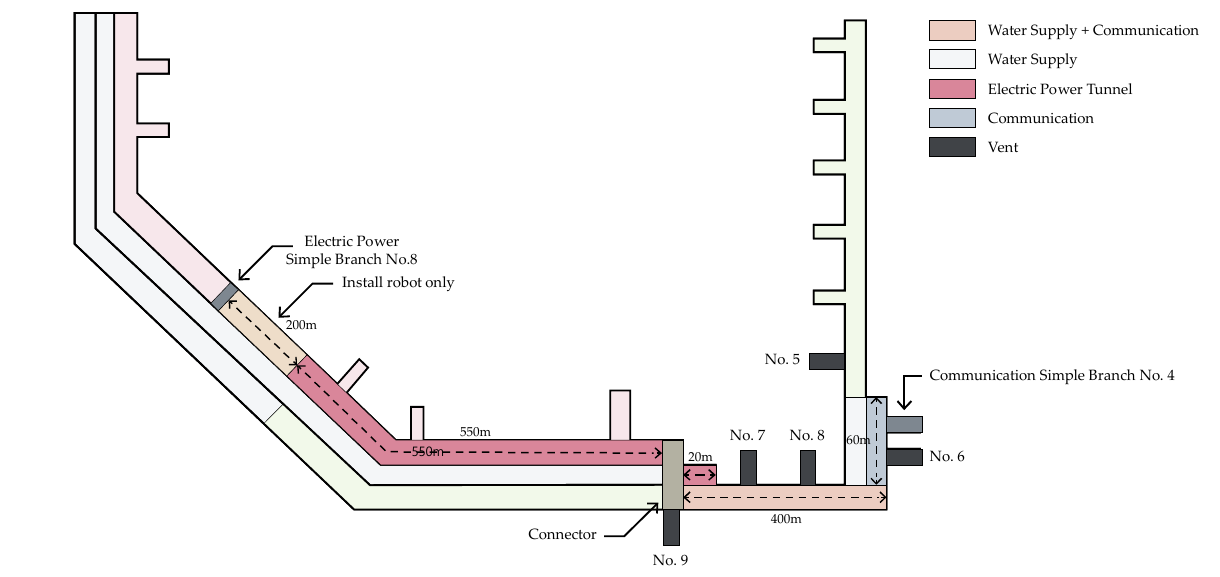
Figure 2. Floor plan of the target underground utility tunnel.